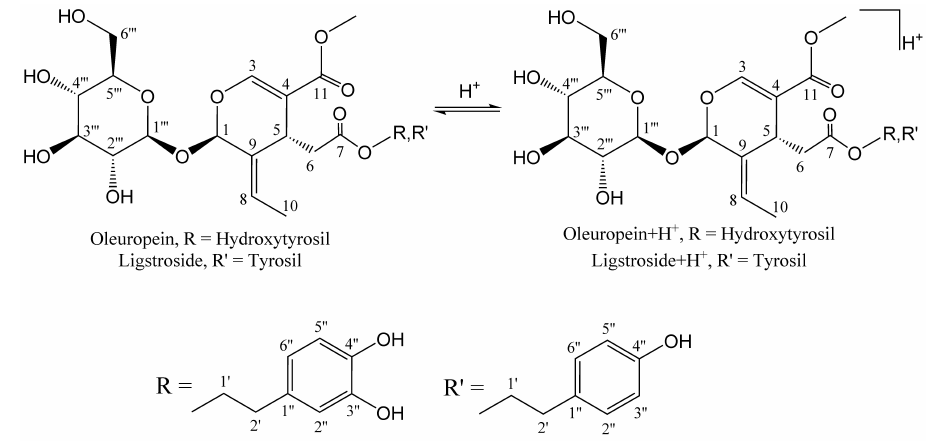
Figure 1. Molecular pre-equilibrium of olive biophenol secoiridoids (BPsecos) and H 3 O + .